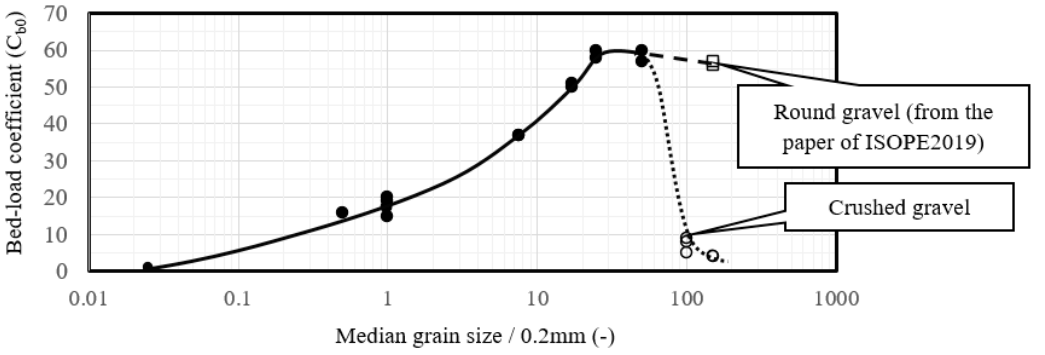
Figure 3. Influence of the median grain size to the bed-load coefficient. (Uniformity coefficients are 1.5–3; dry densities are around 1.5 g/cm 3 ).